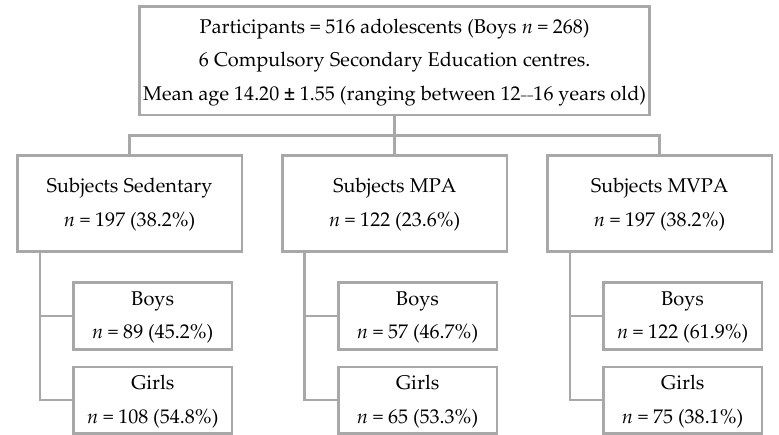
Figure 1. Flow of participants according to the level of physical activity (PA) practice (subjects sedentary, subjects with moderate PA (MPA) and subjects with moderate–vigorous PA (MVPA)) and gender.